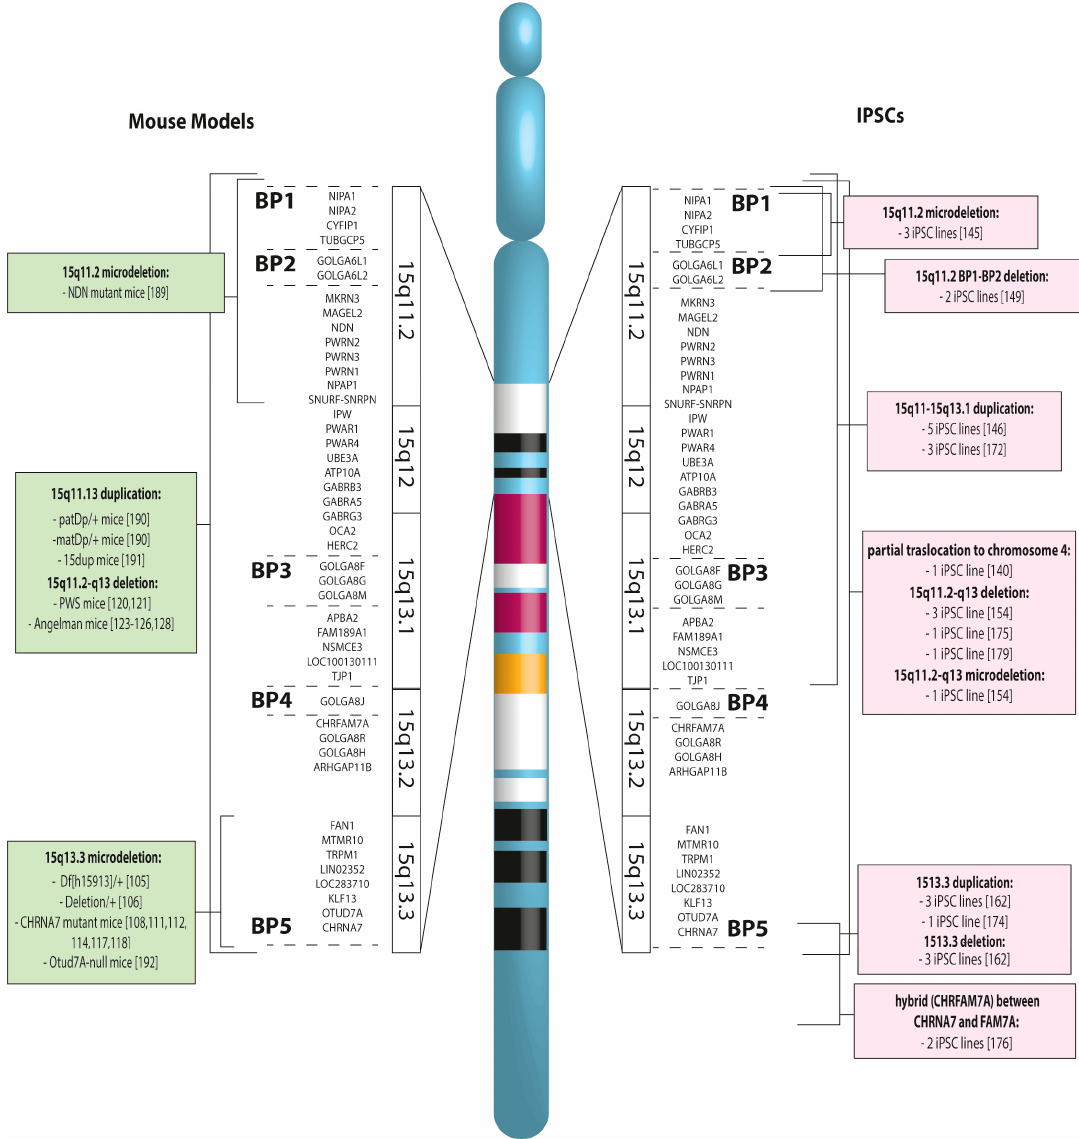
Figure 3. Mouse models and induced pluripotent stem cells (iPSC) lines carrying CNVs of chromosome 15q11-q13. On the left, mouse models syntenic to human chromosome 15q11-q13; on the right, iPSC lines obtained from patients carrying 15q11-q13 CNVs.